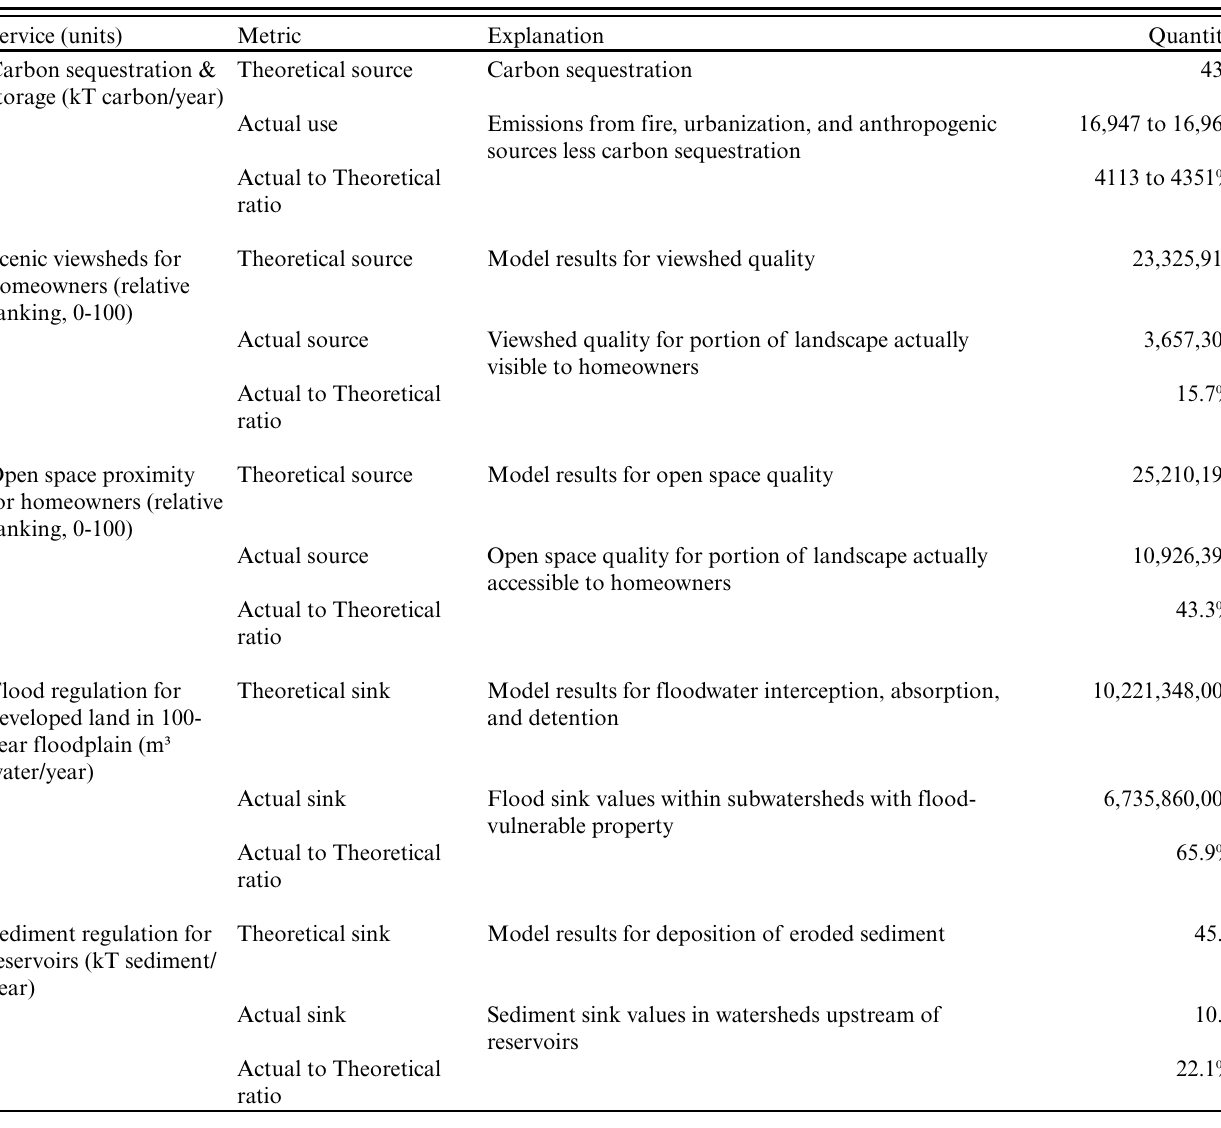
Table 2 . Theoretical and actual service provision and use in Puget Sound